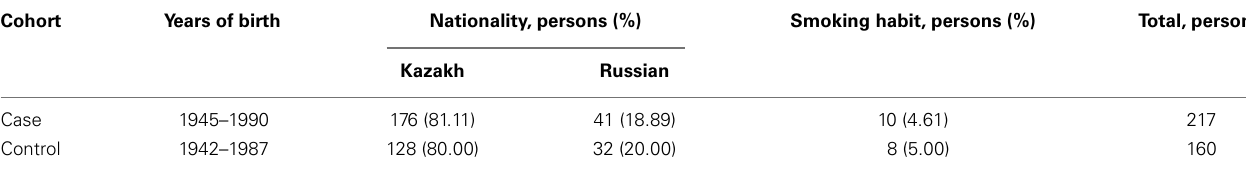
Table 5 |The correspondence of the cervical cancer case and control cohorts by age, ethnicity, and smoking habit.